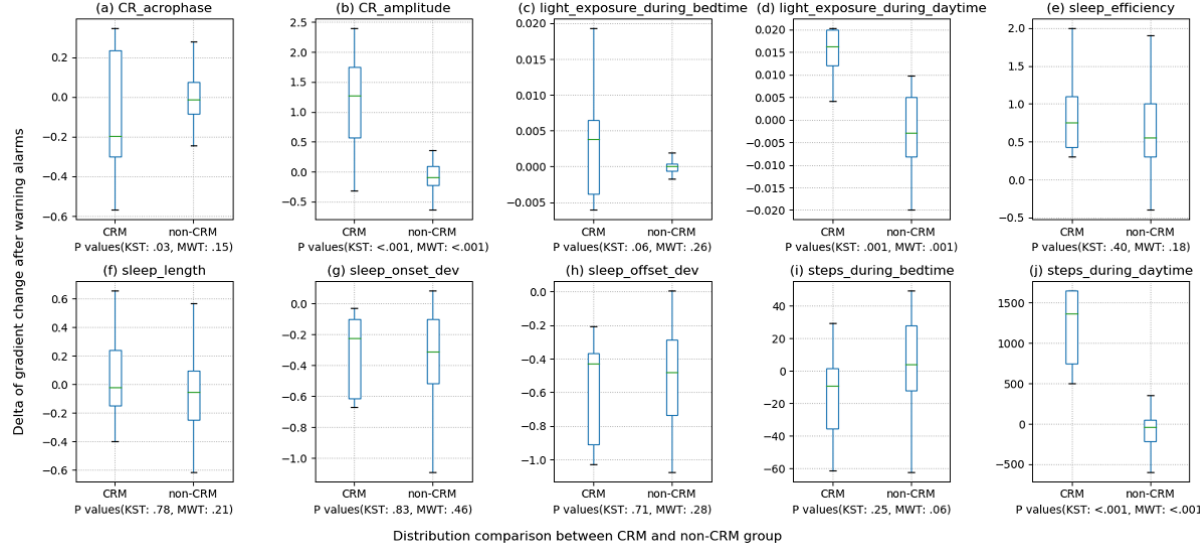
Figure 1. Comparison of the distributions of changes in individual features after receiving warning alerts in the CRM and non-CRM groups. The vertical axis refers to the delta of gradient change (DGC). If the median of the box plot (the green horizontal line inside the box) is near zero, this means that there was no significant change in the feature before and after the warning alert. If the median is greater than zero, this means that the feature value tended to increase after the alert. If it is less than zero, this means that the feature value tended to decrease after the alert. For example, if a patient with low activity during the day received a warning alert and the median of the distribution of the DGC value outcome for the feature steps_during_daytime moves in a positive direction, then we can assume that the patient tried to increase their activity. To compare the DGC distributions of the CRM group and non-CRM group for key features related to the H-score, DGCs were calculated based on each of the time points t at which alarms were activated during the experiment. The system logs for the warning alert calculations recorded the past feedback point t of the alert receivers. The actual warning alert was not delivered to the non-CRM group at time t but delivered only to the subjects in the CRM group at time t. In the comparison analysis, patients whose features could not be calculated due to a lack of data were omitted. CRM: Circadian Rhythm for Mood; KST: Kolmogorov-Smirnov test; MWT: Mann-Whitney U test.